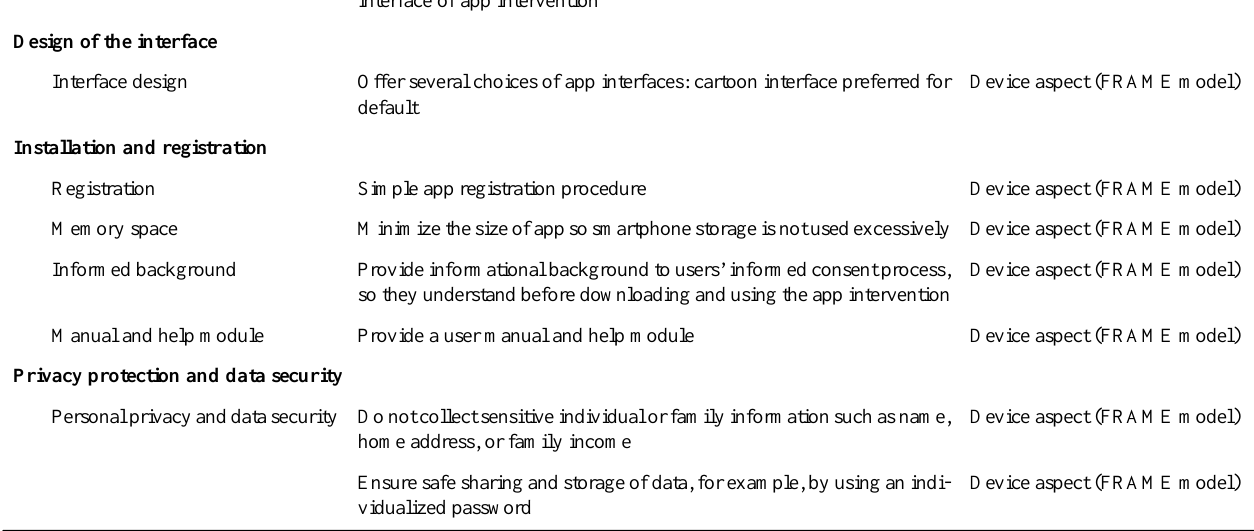
a FRAME: Framework for the Rational Analysis of Mobile Education. b TPB: Theory of Planned Behavior. c Not